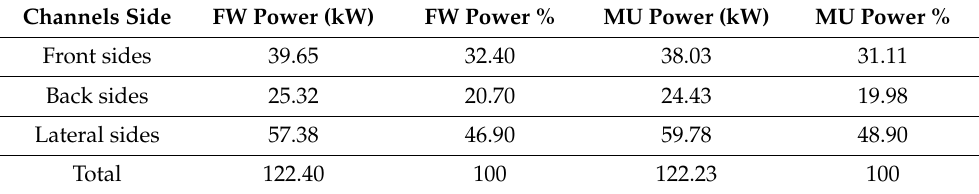
Table 6. Power repartition on the sides of the squared channels in the FW and the MU simulations.